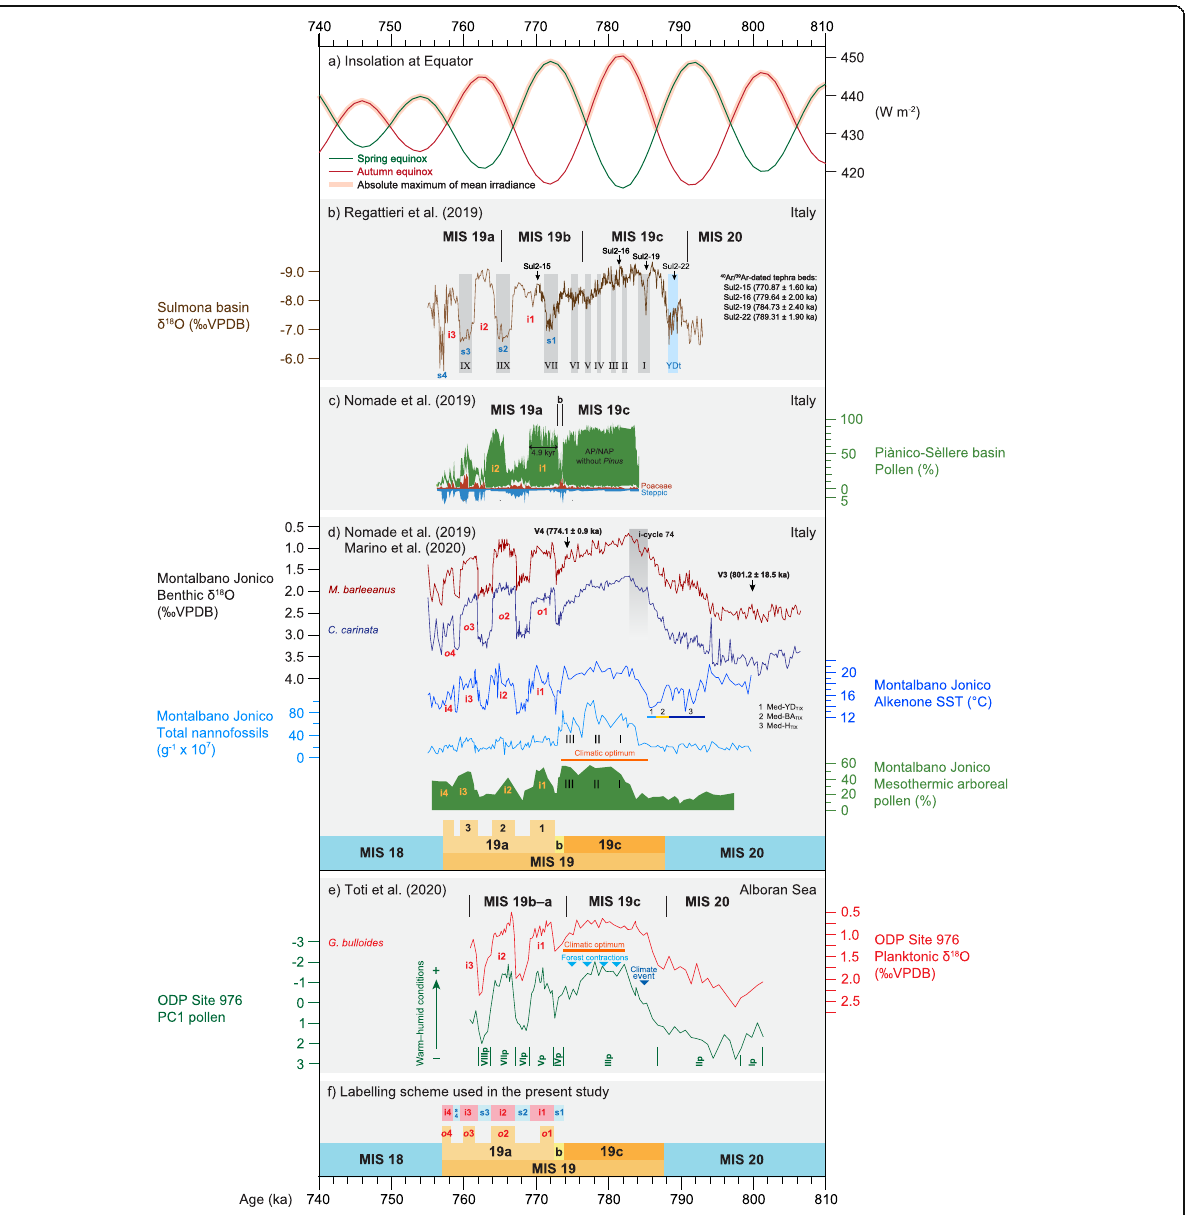
Fig. 10 Mediterranean records of Marine Isotope Stage 19. ( a ) Insolation at Equator in spring and autumn, and absolute maximum of mean irradiance (Laskar et al. 2004; Ferretti et al. 2015; Haneda et al. 2020b). ( b ) Lacustrine Sulmona basin, central Italy: endogenic calcite δ 18 O, events I – IX of reduced precipitation based on δ 18 O, and tephra beds (positions based on modelled ages with 40 Ar/ 39 Ar ages shown separately) used to construct the age model, all from Regattieri et al. (2019); Younger Dryas-like event (YDt) from Giaccio et al. (2015). ( c ) Lacustrine Piànico-Sèllere basin, northern Italy: pollen (Nomade et al. 2019). ( d ) Ideale section, Montalbano Jonico, Italy: benthic foraminiferal δ 18 O and supporting age control using 40 Ar/ 39 Ar-dated tephra (volcaniclastic) beds V3 and V4 from Nomade et al. (2019). Ghost sapropel assigned to insolation cycle 74, alkenone sea-surface temperature (SST) with Heinrich-type (Med-H TIX ) Mediterranean Bølling-Allerød-type (Med-BA TIX ), and Younger-Dryas-type (Med-YD TIX ) episodes associated with Termination IX, and total coccolith abundance and mesothermic arboreal pollen records showing phases I – III of climatic amelioration; from Marino et al. (2020). ( e ) ODP Site 976 Alboran Sea, western Mediterranean: planktonic foraminiferal δ 18 O and pollen (first component of Principal Component Analysis); light blue triangles show temperate forest contractions within MIS 19c and correspond to increases in total coccolithophore abundance; dark blue triangle represents a climate event marked by abundant Asteraceae pollen (Toti et al. 2020). The subdivisional scheme of Nomade et al. (2019) is given. ( f ) The MIS 19 subdivisional scheme used here (Fig. 7): benthic marine isotope oscillations o 1 – o 4 are labelled in red, interstadials i1 – i4 are labelled in red and orange. All records are plotted on their own published time scales and use the original substage